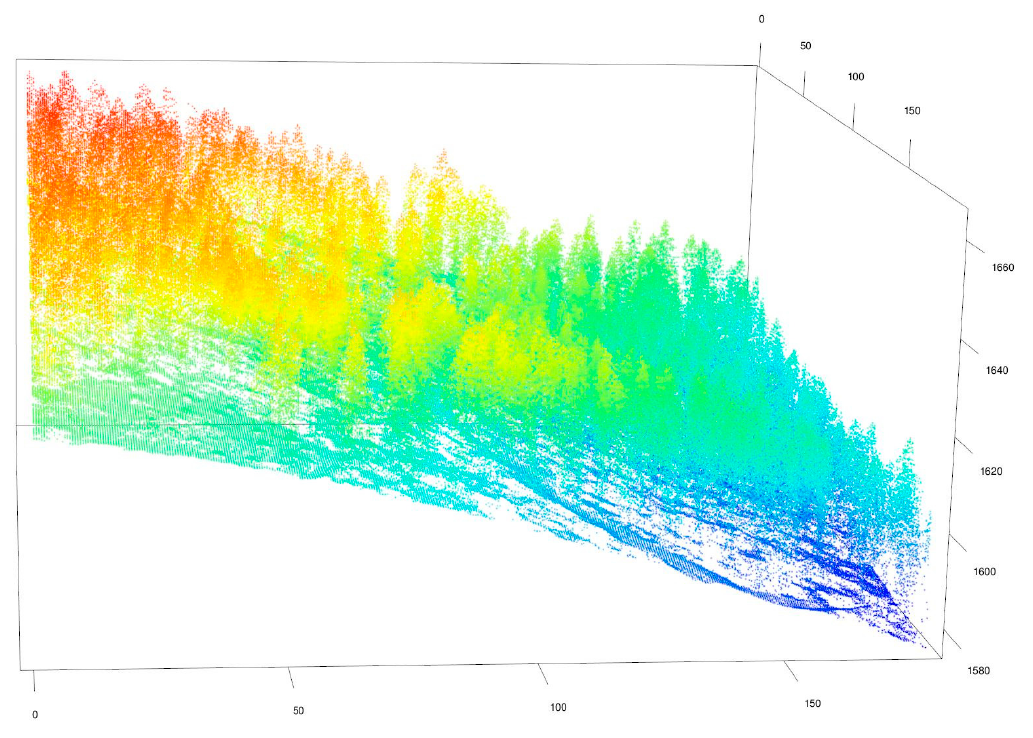
Figure 3. Airborne laser scan of the studied area.